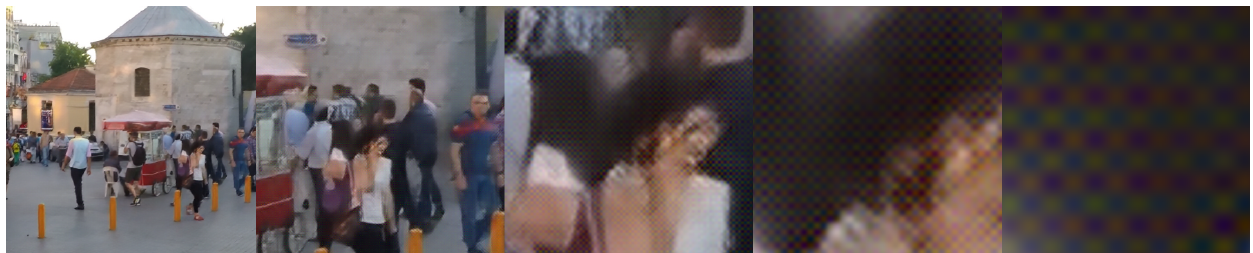
Figure 13. An inferred image by DeblurGAN. We apply the learning method and dataset proposed in [37].